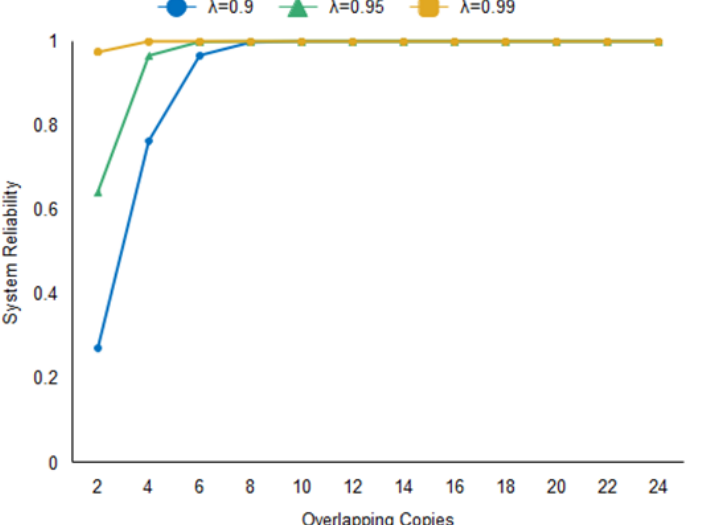
Figure 9. System reliability.